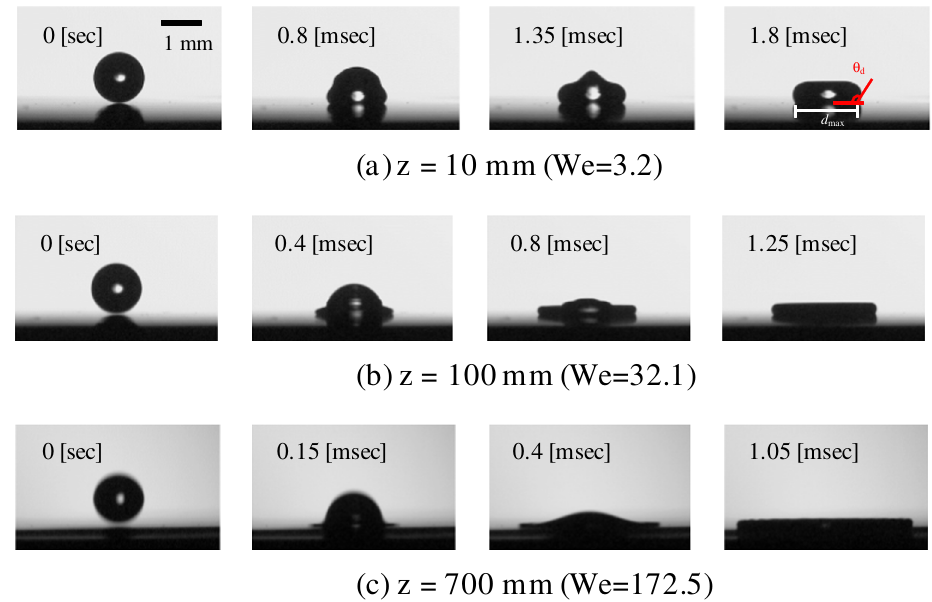
Figure 2. Images of a water droplet impinging on silicone rubber at varying initial drop heights. Images whose drops initially possess ( a ) We = 3.2 ( z = 10 mm), ( b ) We = 32.1 ( z = 100 mm), ( c ) We = 172.5 ( z = 700 mm). Time progresses from the left image to the right image, where the far-right column of images represents drops exhibiting maximum